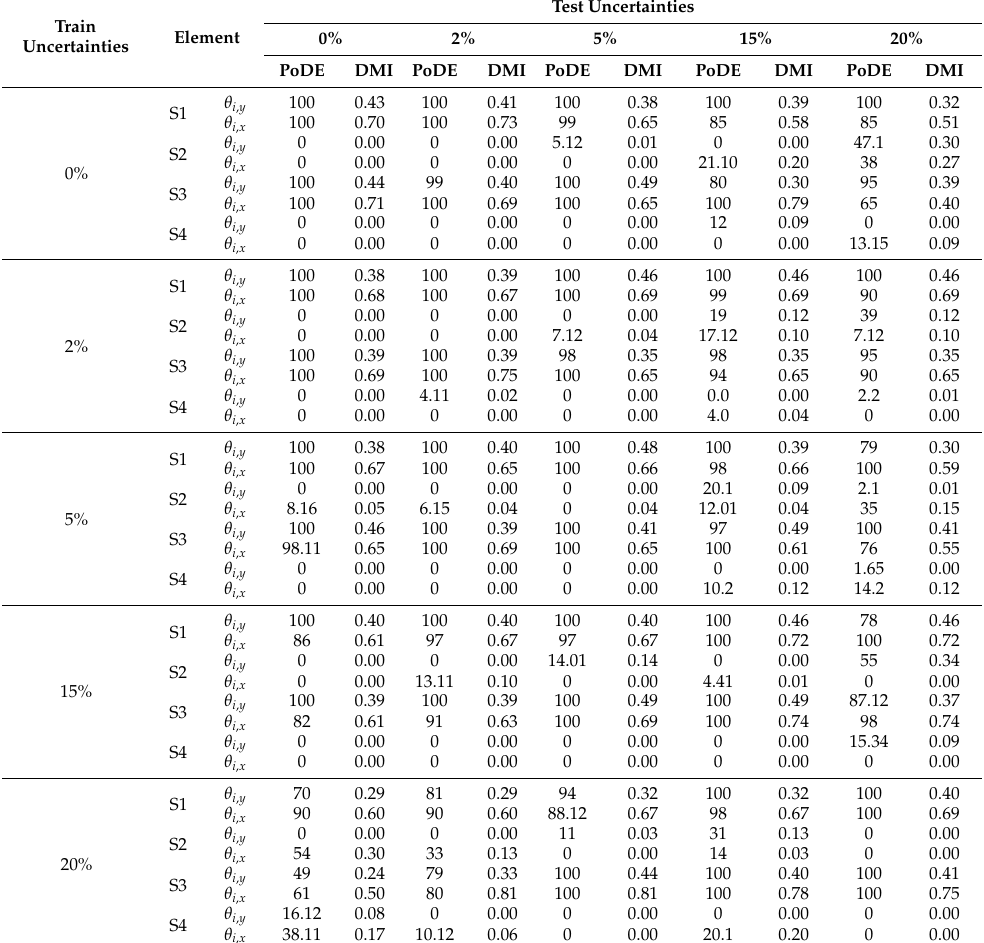
Table 6. PoDE and DMI values for damage pattern 2-damage